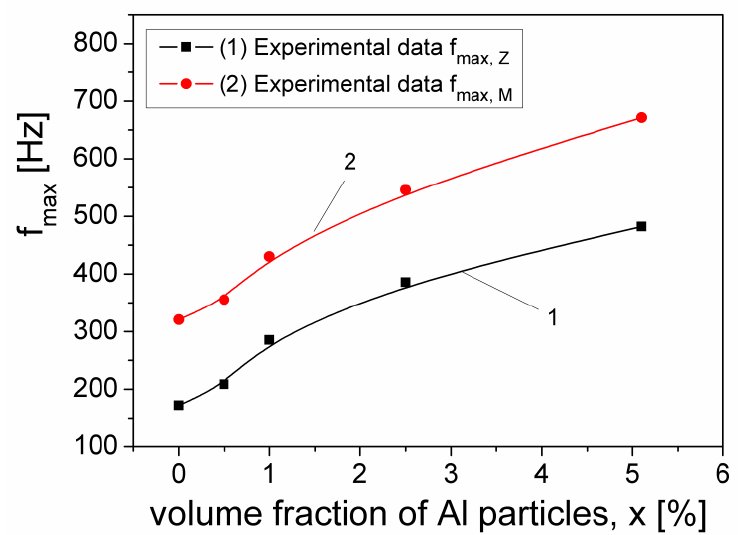
Figure 7. The volume fraction dependence of the f max,(Z) and f max,(M) frequencies, corresponding to the imaginary components Z″ and M″, respectively .